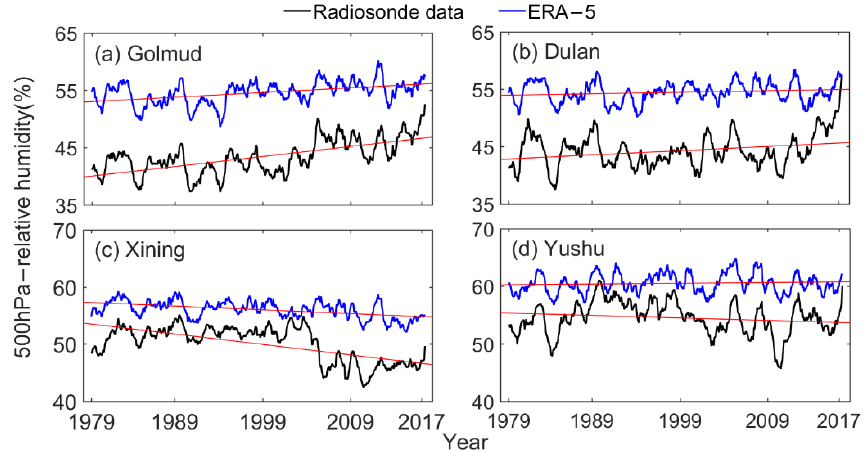
Figure A4. Trends of the monthly moving average of relative humidity for radiosonde and ERA-5 data at 500 hPa. ( a ) Golmud station, ( b ) Dulan station, ( c ) Xining station, ( d ) Yushu